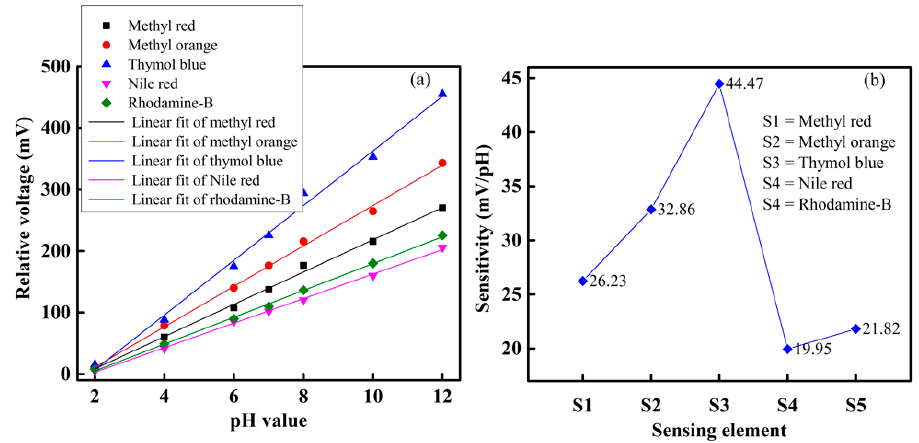
Figure 10. Sensing performance of the proposed optical-fiber pH-sensing system: ( a ) sensing ability; and ( b ) sensitivity.